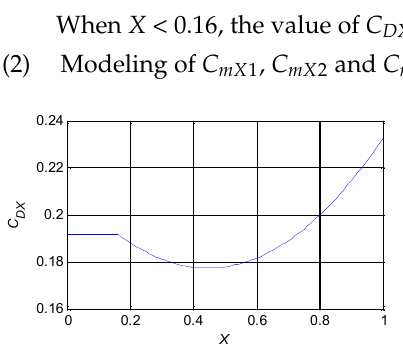
Figure 7. Spline curve of C DX .